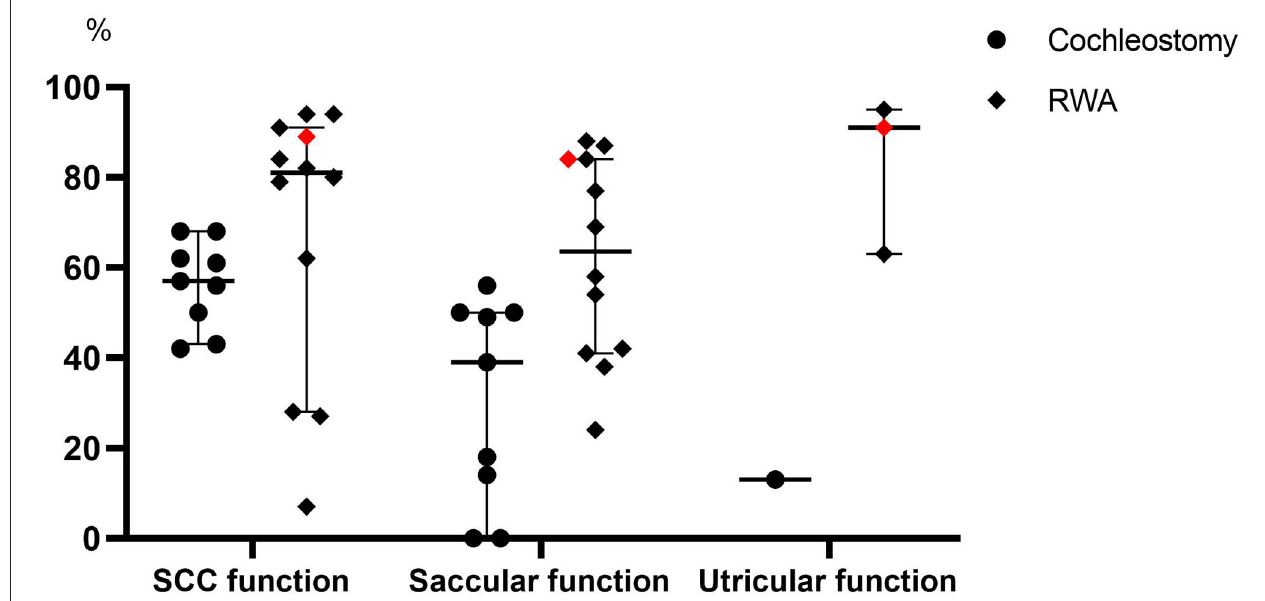
FIGURE 3 | A comparison of the frequencies of vestibular preservation between patients undergoing the RWA and cochleostomy in the literature. The red dots indicate the present results. SCC, Semicircular